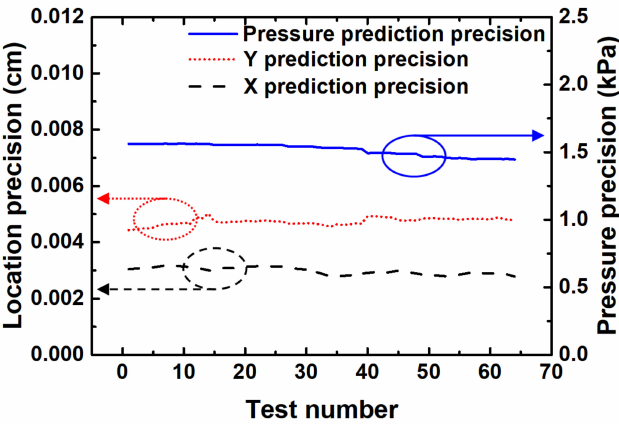
Figure 5. The precision of predicted X , Y , and P . The input precision is dR A 1 = dR B 3 = dR C 2 = dR D 4 = 0.1 Ω .